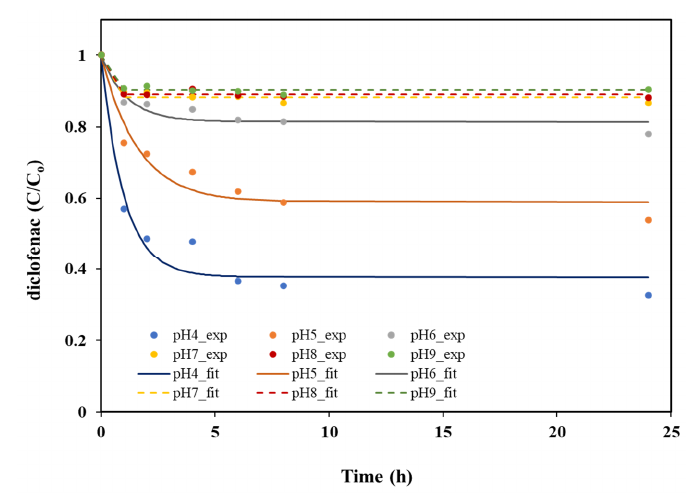
Figure 1. Diclofenac (DIC) oxidation by Mn-oxide. The initial γ -MnO 2 dosage ([MnO 2 ] 0 ) was (100 mg / L) (1150 µ M) and the initial DIC concentration ([DIC] 0 ) was 100 µ M. Dotted symbols represent the experimental data, lines indicate the fitting model, solid lines denote the electron-transfer control mechanism model, dash lines indicate the precursor complex-formation control mechanism model.